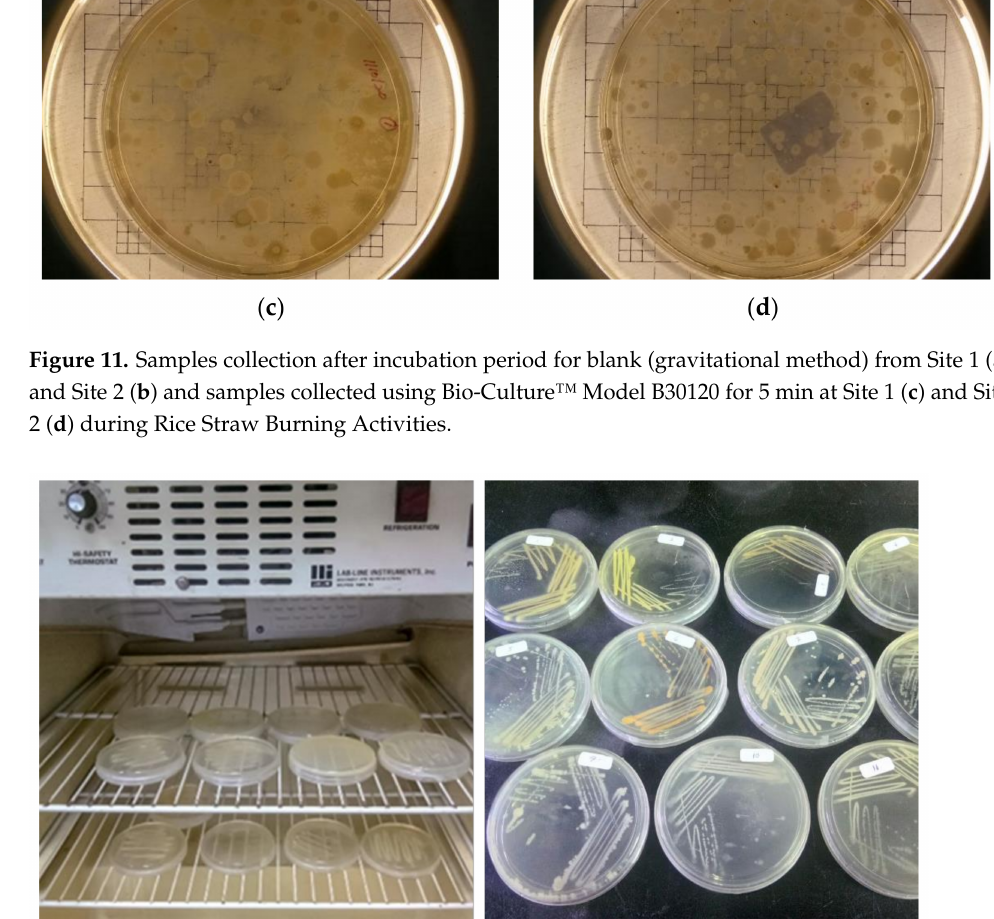
Figure 12. Isolated bacteria were streaked on new plates of nutrient agar and incubates at 37 ◦ C for another 48